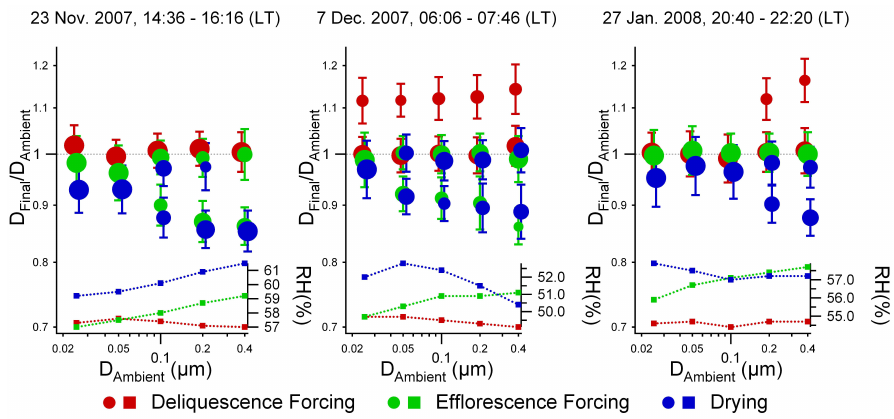
Fig. 7. Results of three AS-TDMA full measurement cycles from the winter campaign. Details of plot formation are given in the caption of Fig.